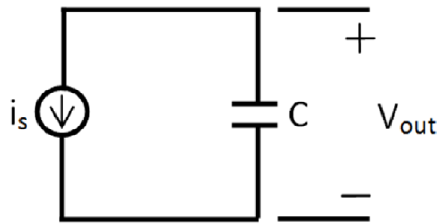
Figure 3. The analogous electrical circuit for zero order